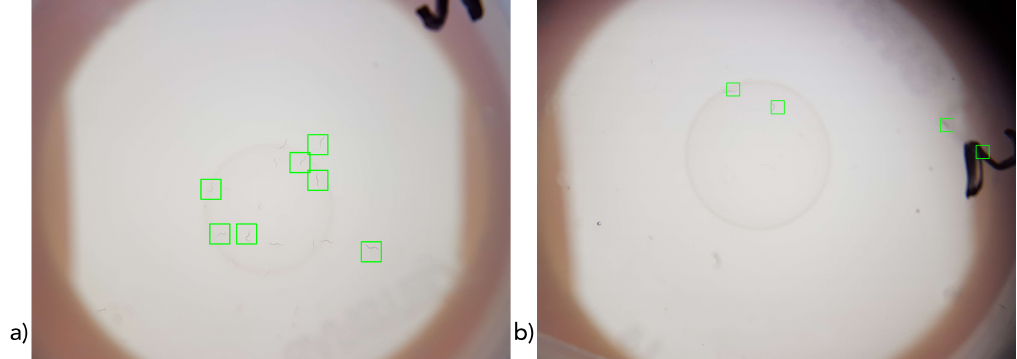
Figure 8. Classification results of example complete classified images. ( a ) Typical result and ( b ) extreme version containing typical low-specificity examples. version containing typical low-specificity